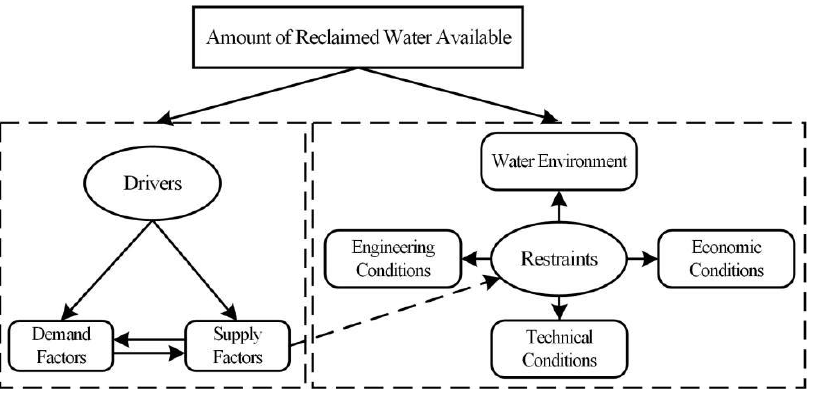
Figure 3. Framework of non-recursive structural mechanisms for factors affecting reclaimed water utilization.